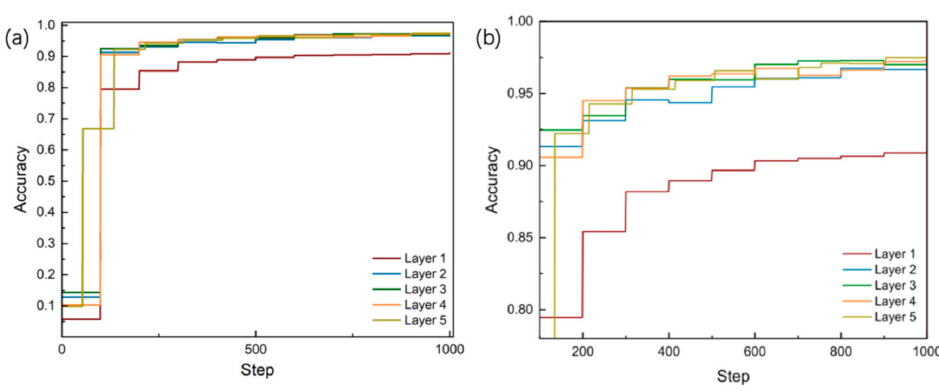
Figure 8. Train accuracy with noise ( a ) Accuracy from step 1. ( b ) Accuracy form step 100.